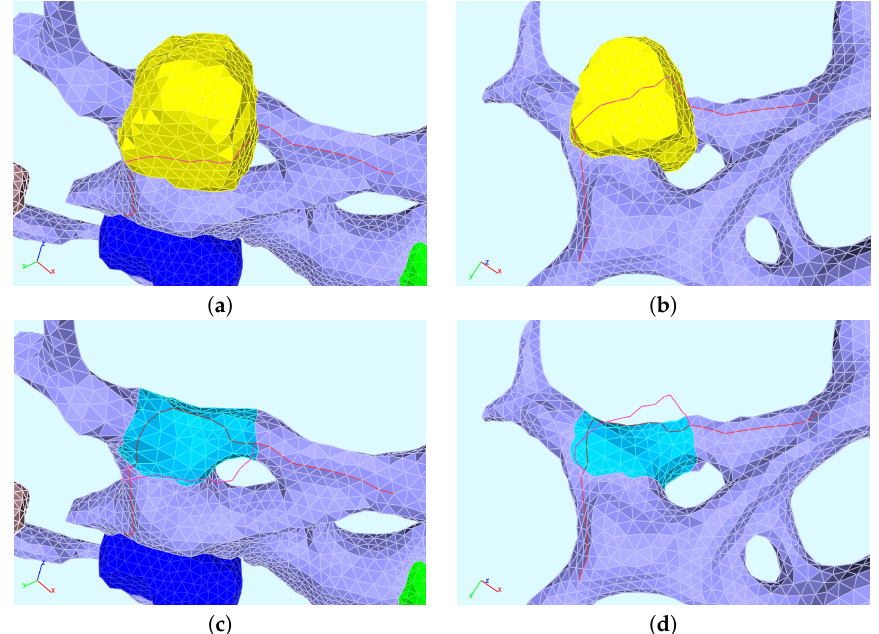
Figure 3. Evaluation of the concentrations along the shown pathways (four perspectives of the path: path on ER and web surface, path on the ribosomes, with and without the web visible). Path from right to left. The sub paths are the four red lines, which start/end where another subdomain begins (besides the external beginnings on the ER, left and right). ( a ) path on ER and web surface, web visible, ( b ) path on ER and web surface, web visbile, slightly changed perspective, ( c ) path on ER and ribosomes, web invisible, ( d ) path on ER and ribosomes, slightly changed perspective.